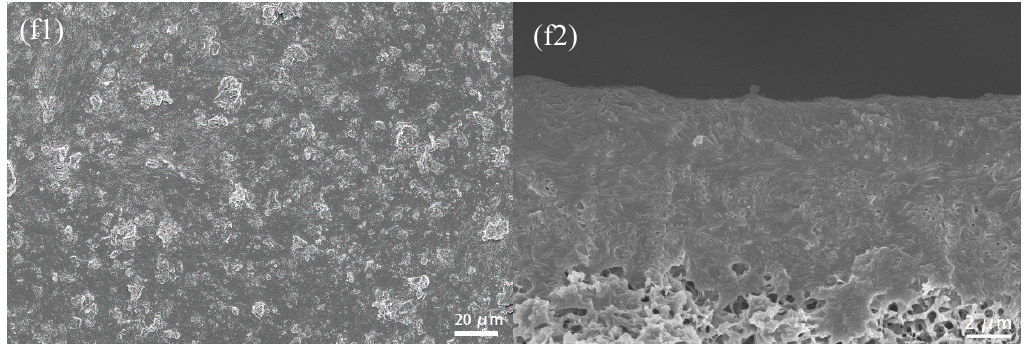
Figure 5. Surface and cross-sectional SEM images of the MMMs: ( a ) CuBTC-0%, ( b ) CuBTC-1%, ( c ) CuBTC-2%, ( d ) CuBTC-3%, ( e ) CuBTC-4% and ( f ) CuBTC-5%.